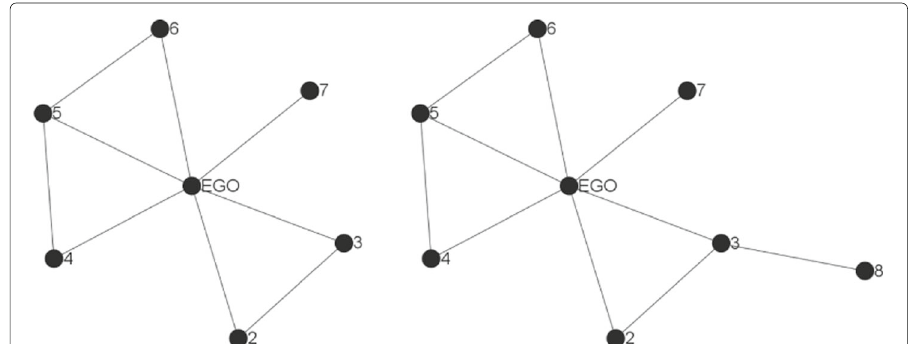
Fig. 2 1-level and 2-level ego-networks